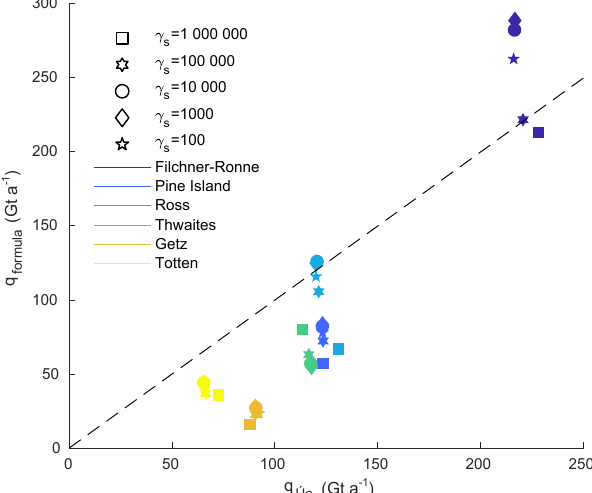
Figure B5. Comparison of fluxes calculated with Úa ( x axis) and with the analytical flux formula ( y axis, using θ 1 ), integrated along the grounding lines of the ice shelves indicated in the legend. Sym- bols indicate the different regularisation parameters γ s . All other parameters agree with the reference run (indicated by a circle). The dashed line shows where fluxes calculated with Úa and predicted by the formula would